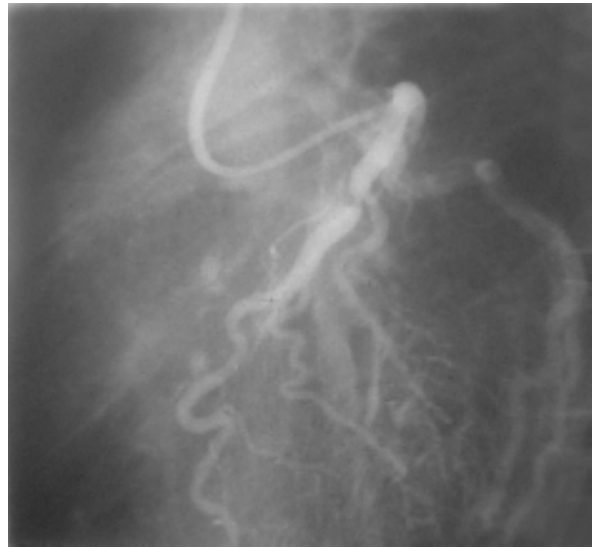
Fig. 3 - Coronariografia do caso 3 mostrando ramos diagonais comunicando-se com o ventrículo